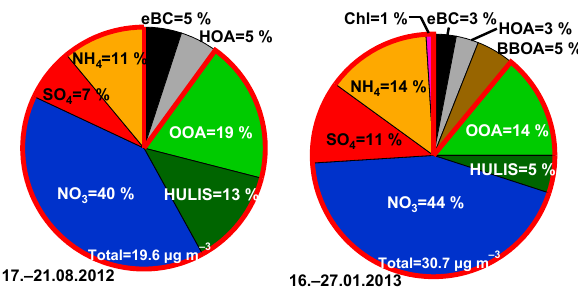
Figure 6. Average contributions of individual aerosol species and PMF factors during selected pollution events. Surrounded red re- gions represent the secondary aerosol